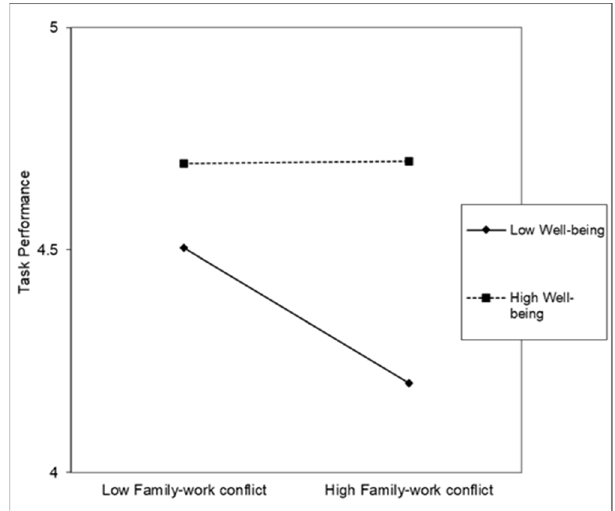
Figure 12. FWC x Well-being interaction chart